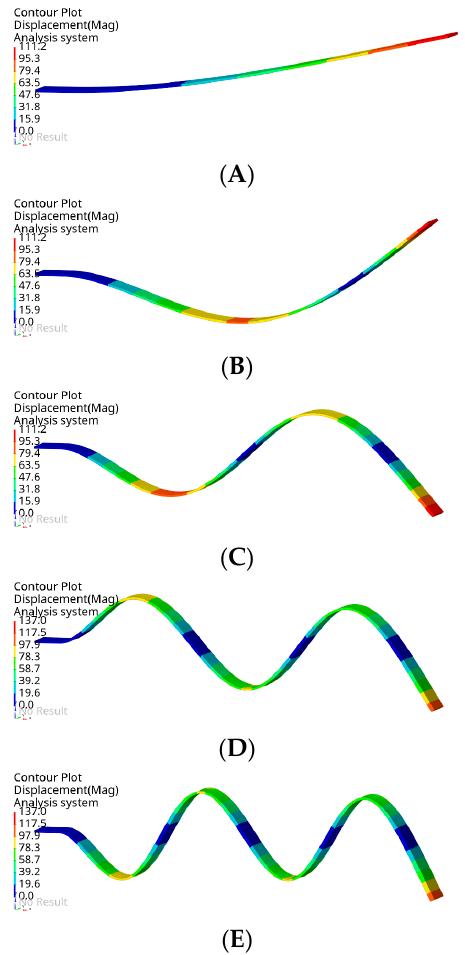
Figure 6. Graphical representation of computed normal modes: first bending mode ( A ), second bending mode ( B ), third bending mode ( C ), fourth bending mode ( D ), and fifth bending mode ( E ).